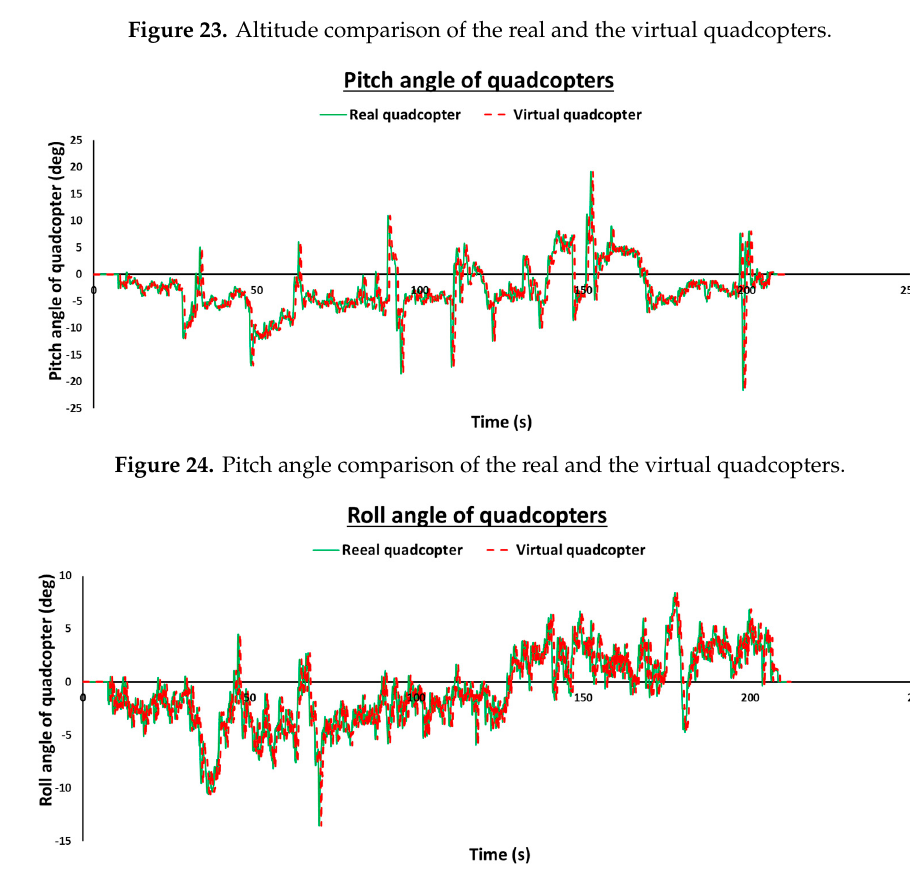
Figure 25. Roll angle comparison of the real and the virtual quadcopters.